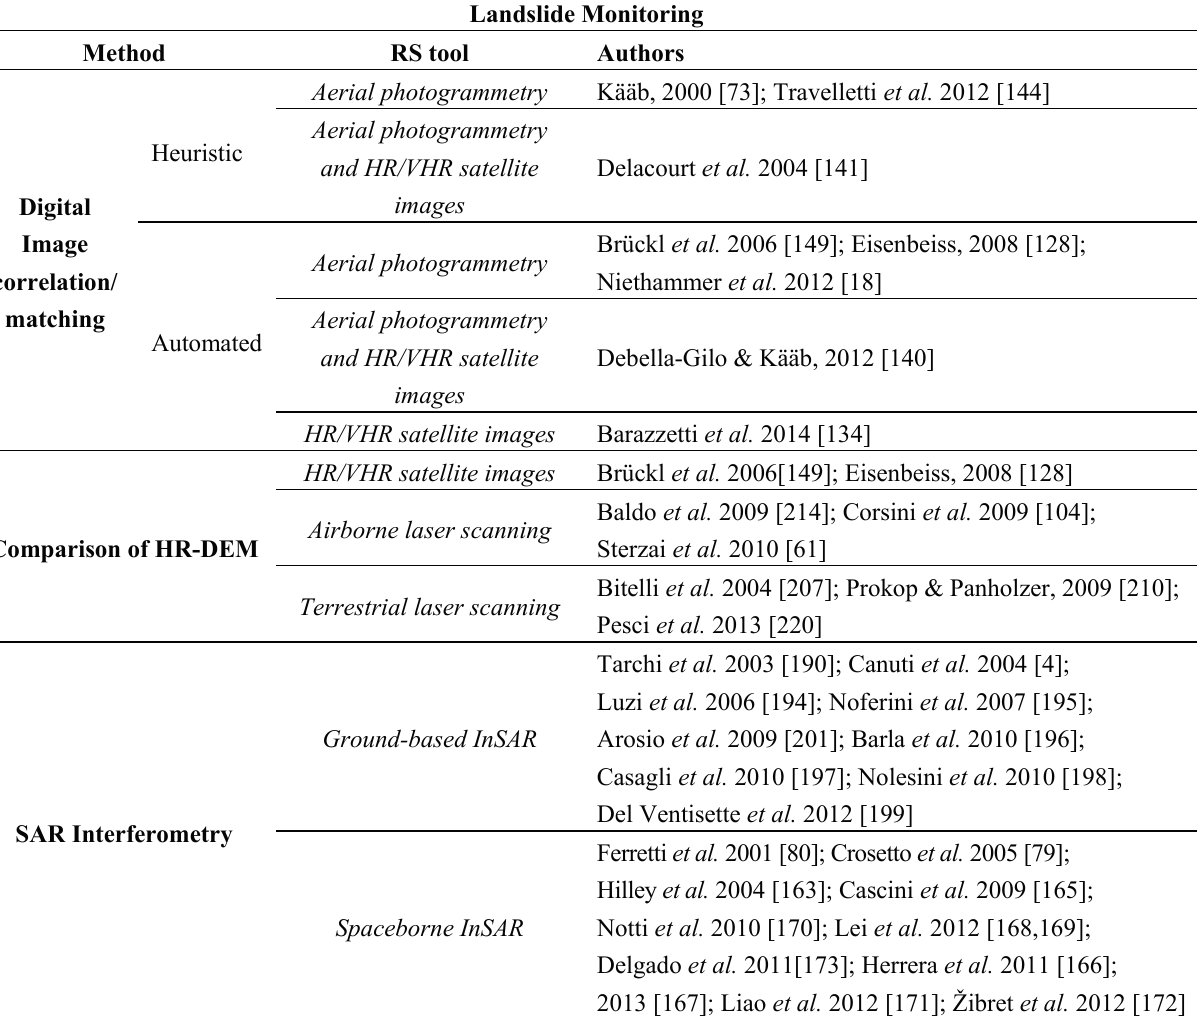
Table 2. Literature contributions to Remote Sensing techniques applied to landslide